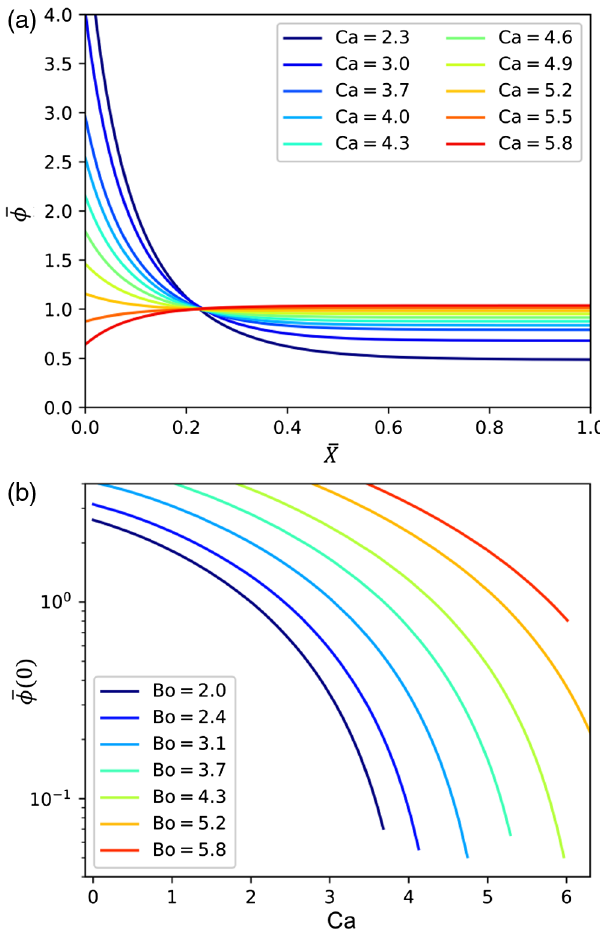
FIG. 5. Ca versus Bo experimental phase diagram. Symbols are ¯ ϕ FIG. 4. (a) Evolution of the dimensionless liquid fraction as a associated to the mean bubble radius: red, R ¼ 1 . 0 mm; blue, function of the dimensionless altitude X obtained numerically for R ¼ 2 . 6 mm; green, R ¼ 4 . 3 mm. Plain circles represent stable a Bond number equal to 5.3 and different effective capillary foams and crosses represent foams where avalanches are re- numbers Ca. (b) Theoretically predicted dimensionless liquid ported. The continuous gray area is obtained numerically and ¯ ϕ corresponds to (Bo;Ca) values for which ϕ ð 0 Þ ¼ 0 . 1% given the fraction at the bottom of the sample ð 0 Þ as a function of the initial liquid fraction effective capillary number Ca for different Bond number Bo.